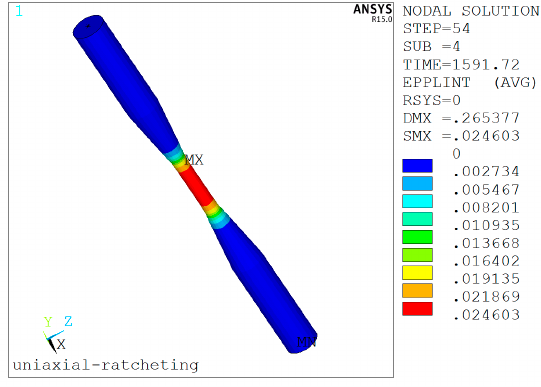
Figure 18. The total plastic strain of the finite element model.